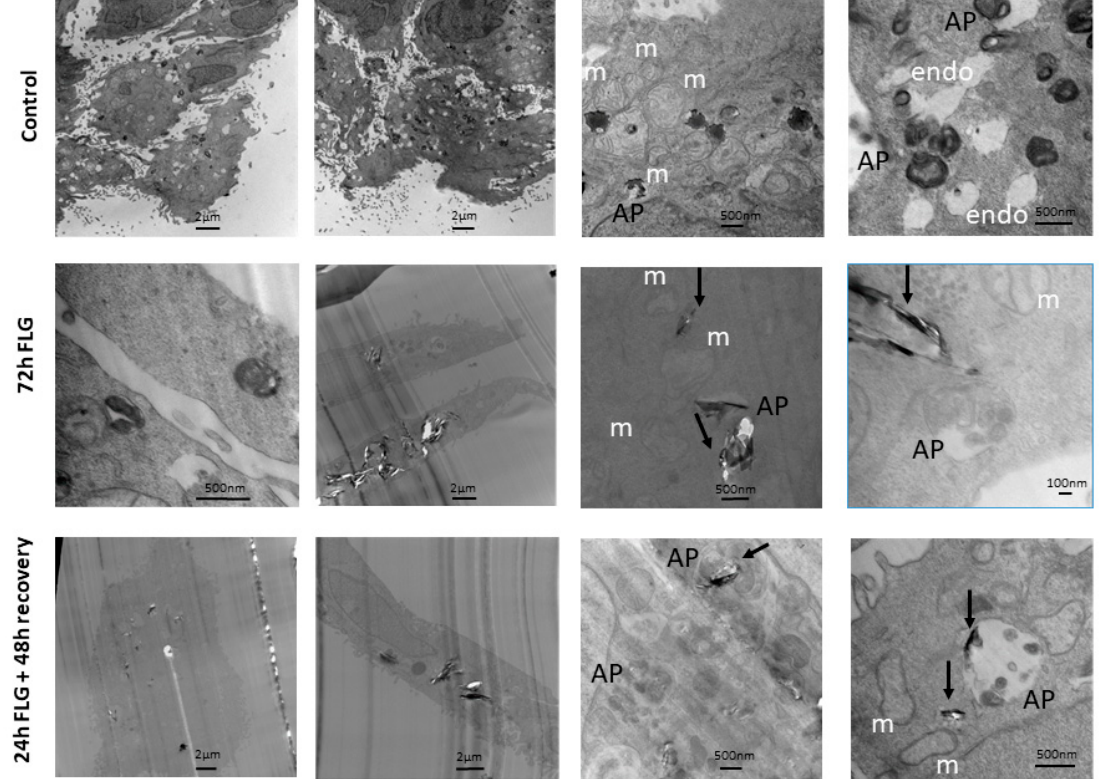
Figure 5. Transmission electron microscopy (TEM) of HaCaT cells exposed to FLG. HaCaT cells were exposed to FLG (100 μ g/mL) for 24 or 72 h (continuous exposure) or for 24 h followed by 48 h recovery in GBM-free medium (recovery exposure; 24 + 48 h) before fixation and preparation for TEM. The panels on the left half show almost entire cells at lower magnification, while the panels on the right half show cells at higher magnification. (m, mitochondria, AP, autophagosome, endosome).